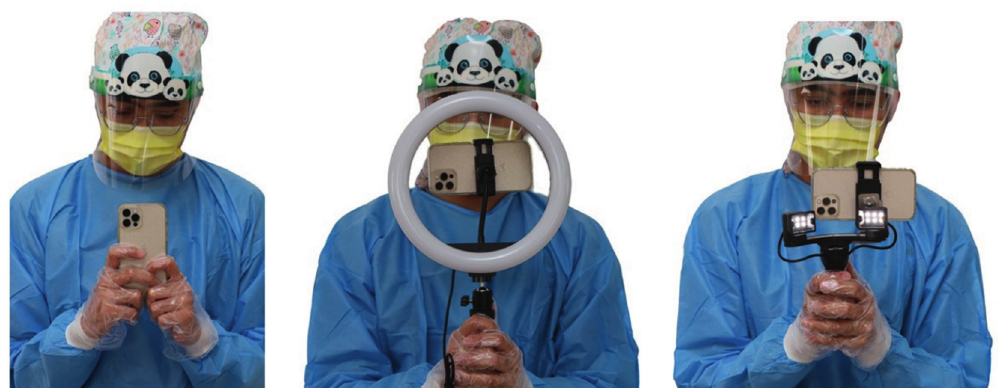
Figure 3: Methods of holding a smartphone.